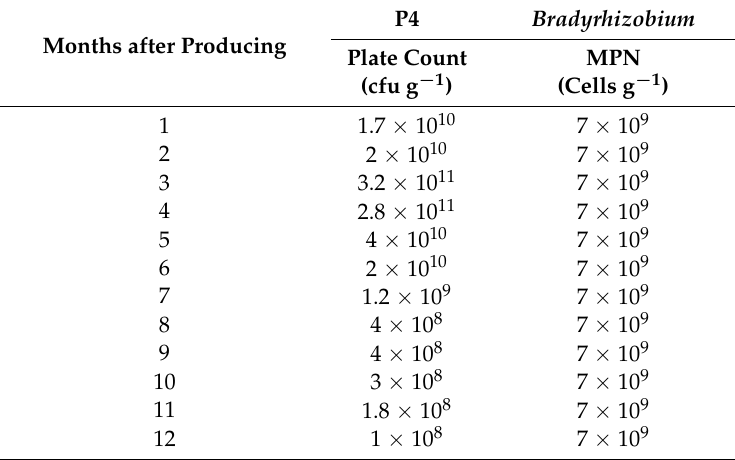
Table 3. Survival of P4 and Bradyrhizobium on peat